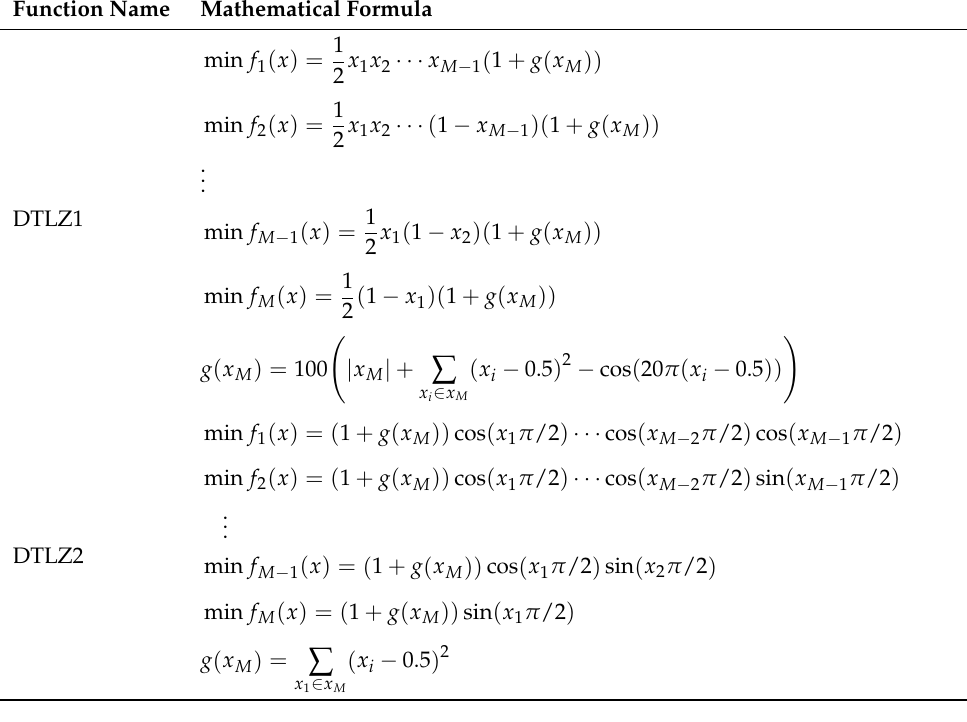
Table 4. DTLZ Test functions and